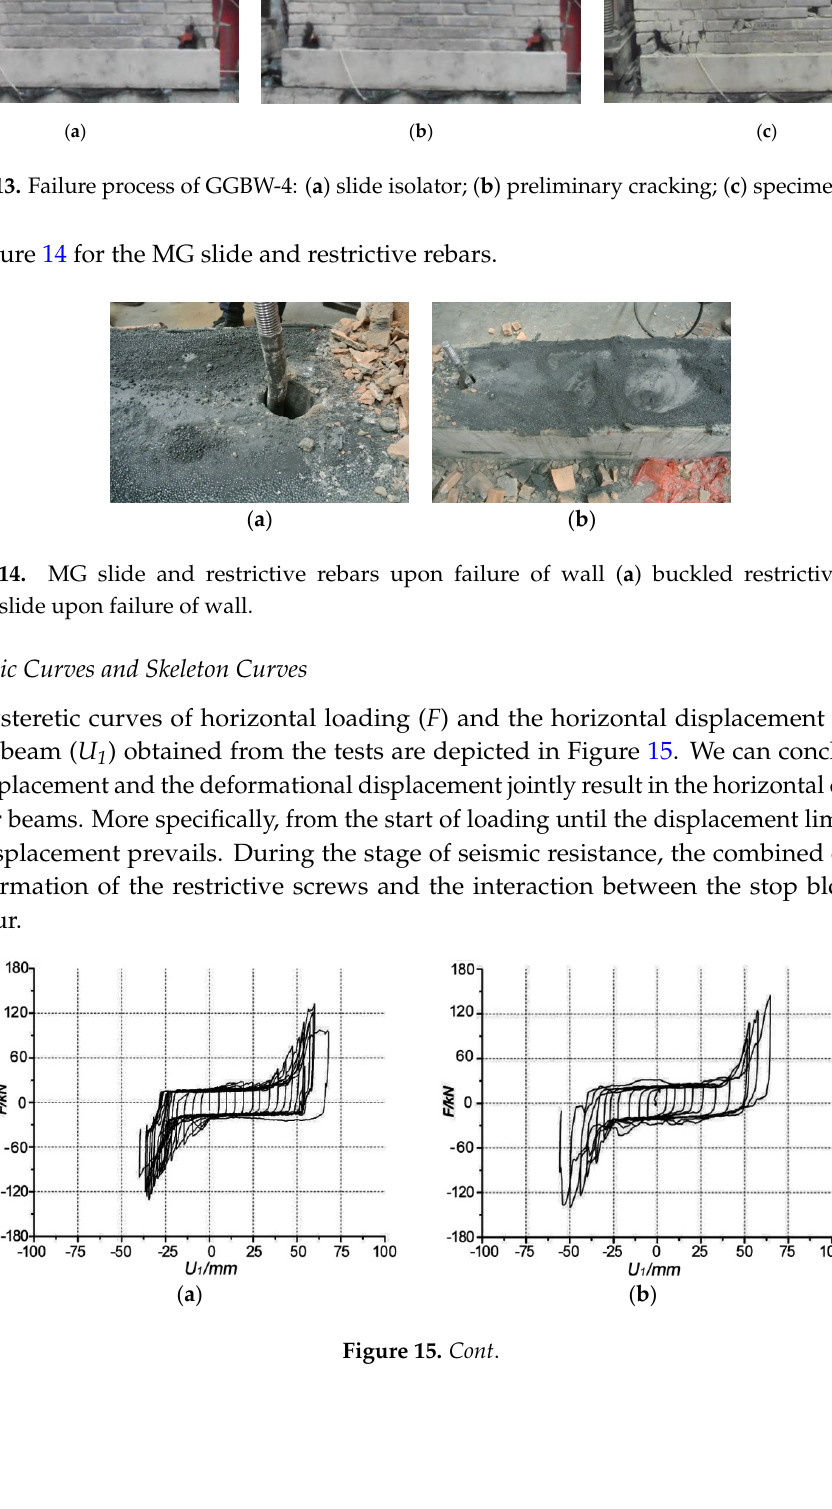
Figure 12. Failure process of GGBW-3: ( a ) slide isolator; ( b ) preliminary cracking; ( c ) specimen failure.